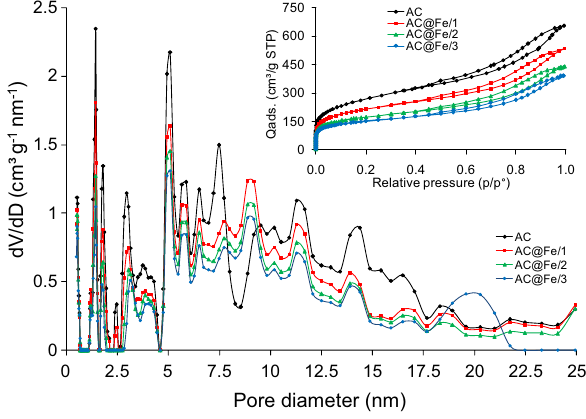
Fig. 4 AC and heterogeneous catalysts PSDs from N 77 K. Inset: N 2 adsorption–desorption isotherms of the AC support and AC@Fe/1, AC@Fe/2 and AC@Fe/3 catalysts